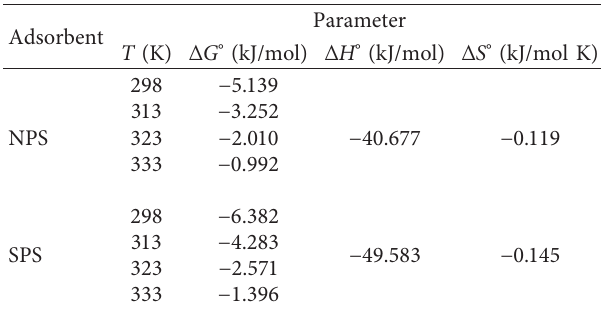
Table 4: Thermodynamic parameters for the FD removal by NPS and